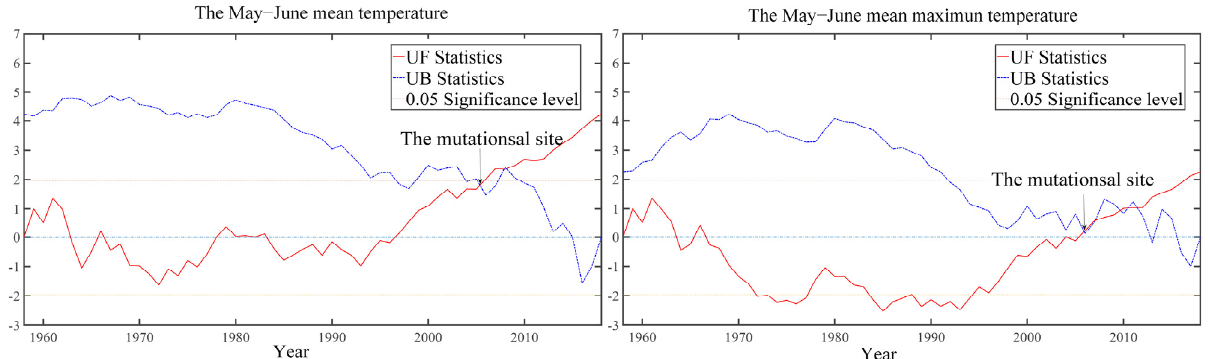
Figure 6. Mann–Kendell tests of T MJ and Tmax MJ at the Tongbai meteorological station from 1958–2014.